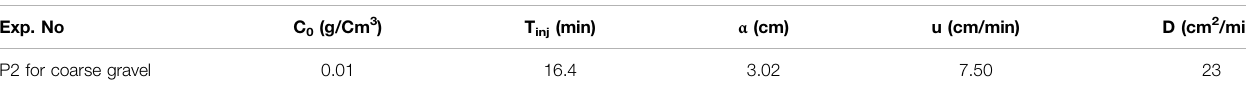
TABLE 8 | The calculated values of the parameters for the plastic particle experiment P2 for coarse gravel. Exp. No C 0 (g/Cm 3 ) P2 for coarse